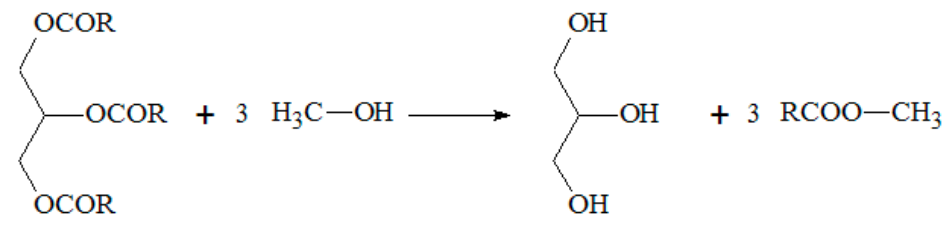
Figure 1. Reaction equation of the transesterification process.